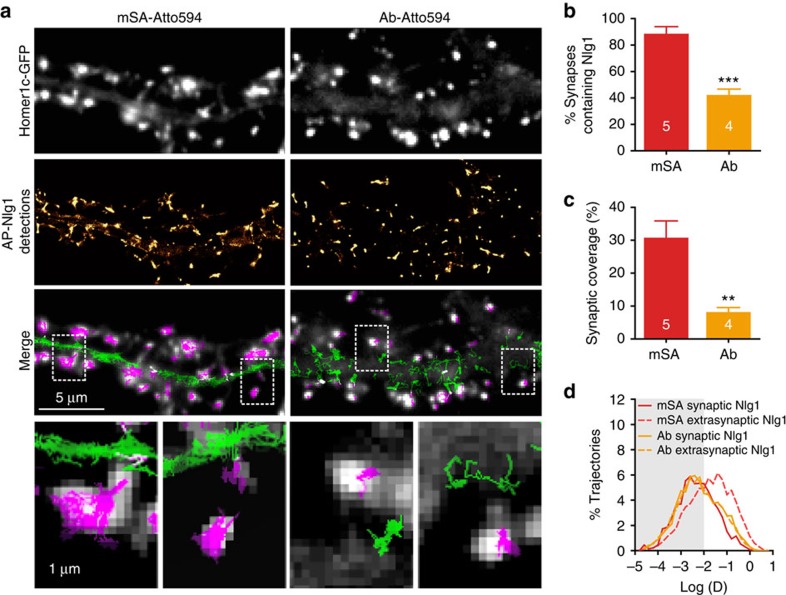
Different ability of mSA and biotin antibody to label AP-Nlg1 within the synaptic cleft in live conditions.(a) DIV 15 neurons expressing Homer1c-GFP, AP-Nlg1 and BirAER were labelled with mSA or anti-biotin conjugated to Atto594 to track individual AP-Nlg1 molecules by uPAINT. From top to bottom: Homer1c-GFP signal staining mature synapses; super-resolved AP-Nlg1 detection maps; merged images showing extrasynaptic AP-Nlg1 trajectories (green) and synaptic trajectories (magenta) overlaid with Homer1c-GFP signals (grey); insets show that mSA-stained Nlg1 fills the entire synaptic area, whereas antibiotin remains on the edge of the postsynaptic density. (b) Percentage of synapses containing AP-Nlg1 labelled with mSA or biotin antibody (***P<0.0001). (c) Percentage of the synaptic area occupied by AP-Nlg1 when labelled with mSA or anti-biotin (**P<0.01). (d) Semi-log distribution of synaptic (solid lines) and extrasynaptic (dashed lines) diffusion coefficients for AP-Nlg1 measured with the two different probes. Data are from two different experiments. Numbers in the bar charts represent the number of cells analysed.